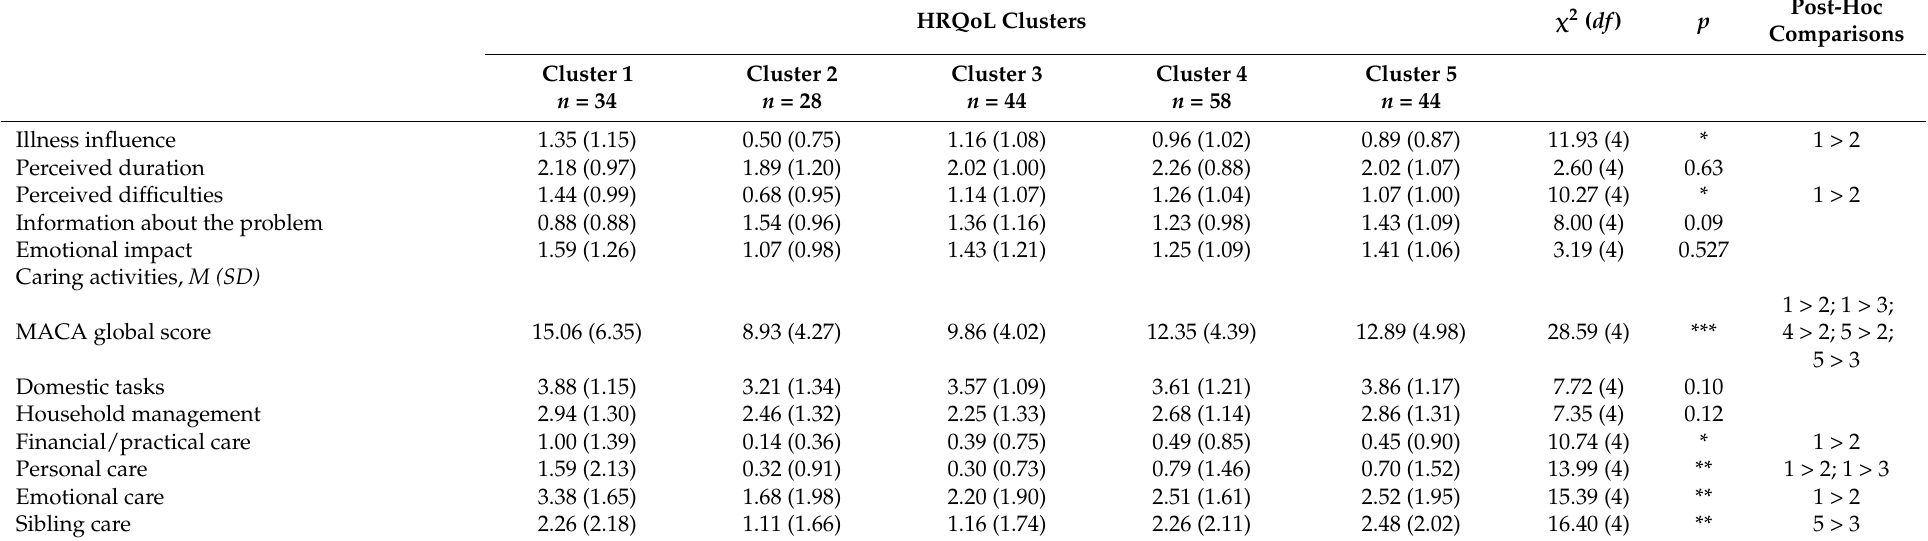
Table 3. HRQoL Cluster